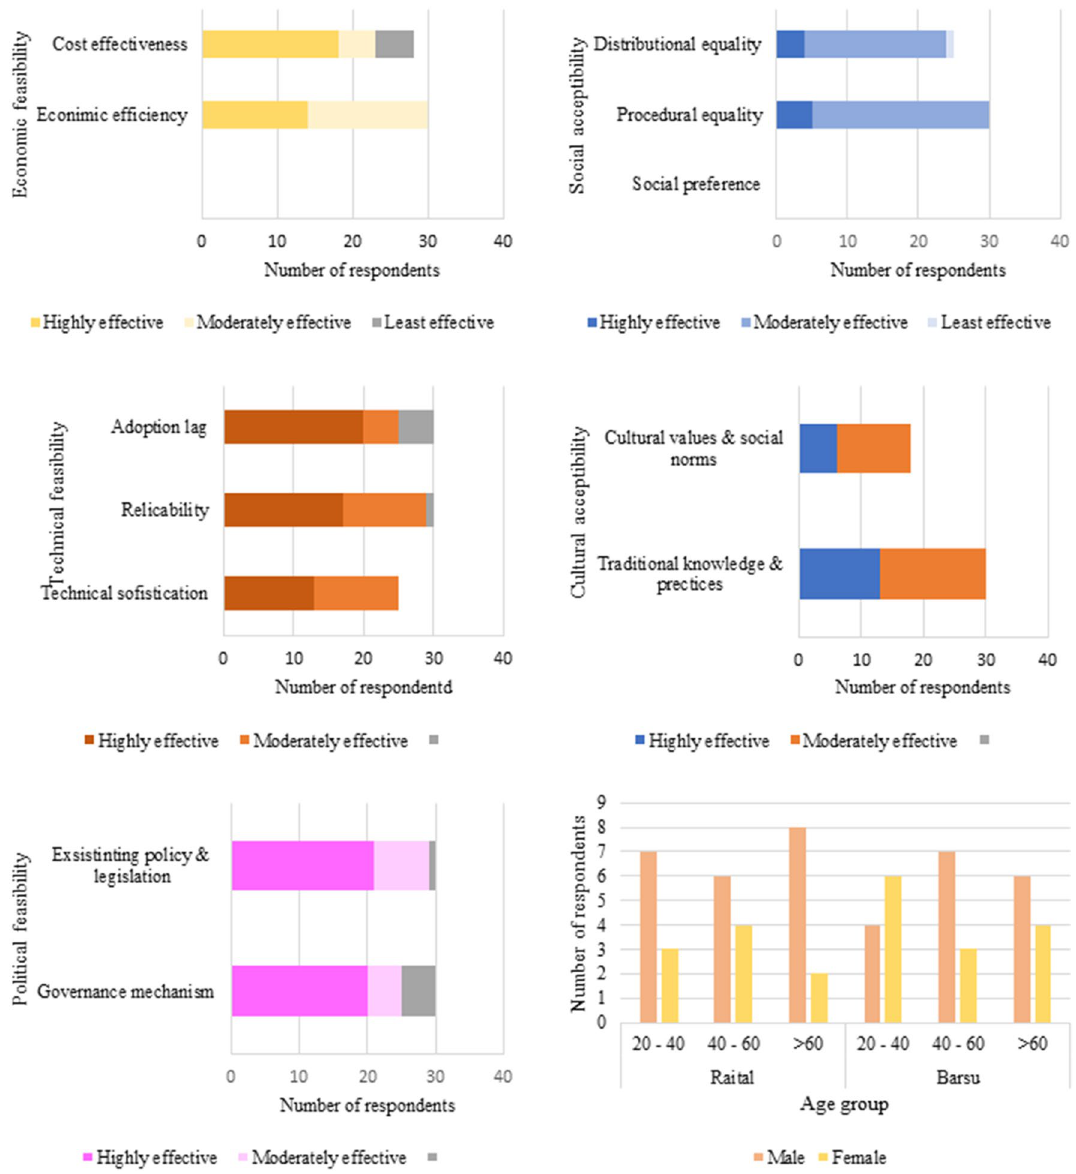
Figure 5. Socio-economic responses by the local stakeholders regarding feasibility assessment criteria related to the Dayara bugyal Himalayan Region. Like, overgrazing is reported for the areas of high altitude grasslands of Kashmir, Tungnath, Garhwal in the Indian Himalaya, Sagarmatha (Mt. Everest) National Park, Nepal and China 25–28 , and other places of the Himalaya. In case of the Dayara bugyal, local livestock populations were found to be increased at a rate of 33 CU per year and also evaluated to be more responsible for overgrazing. Migratory livestock unit was found to be controlled after the restoration phase. Overgrazing is strongly associated with soil cracking and vegetation disturbance, important processes and features of degradation in alpine ecosystems 29 . Shifting of grazing land from Dayara towards Lambidhar was an excellent management measure in this aspect, where more control measures are needed. According to our calculations, if 445 CU will be deducted from the local livestock from Dayara, grazing will be under carrying capacity. Therefore, the grazing pattern of 118 migratory CU (76 horse/mule and 18 sheep/goat, already controlled) and 318 local CU (30 horse/mule and 187 sheep/goat, need to be controlled) is recommended for the area. Rest of the animals may be shifted to some other areas like Lambidhar, Devkund, and Suriyatop. One check post for checking the livestock should be made in this regard. Further, in alpine region, tourism is also reported to reflect impacts like reduction in litter biomass, soil nutrient supply and soil enzyme activities, generation of solid waste, thus adversely affect the whole plant-soil system 30 . On the other hand, tourism sector is considered as growth engine for the future development of the Indian Himalayan Region 31 . In Uttarakhand, due to lack of attentive strategies, and the existing policy framework, incongruous practice of tourism, unplanned developmental activities, and the massive inflow of visitors are